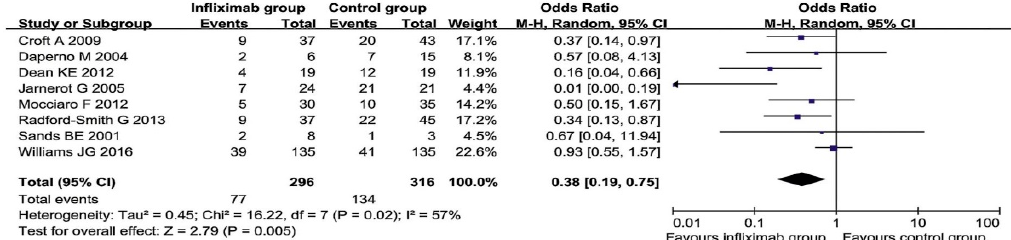
Figure 9. Forest plot of colectomy rates in the infliximab group of patients for 3 months and in the control group [104].